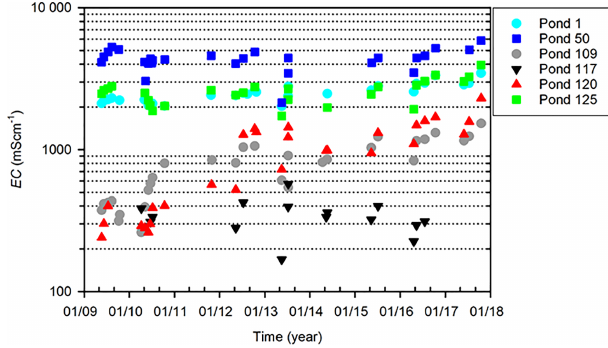
Figure 5. Time series of pond water electrical conductivity (log scale) at St. Denis showing the variations in pond